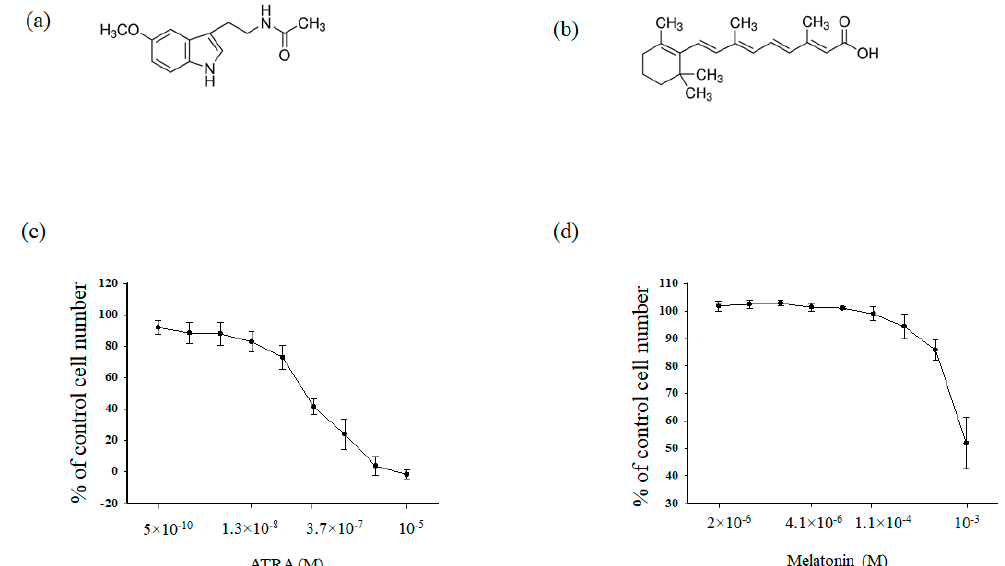
Figure 1. Upper part ( a ) and ( b ). Chemical structures of melatonin (MEL) and all-trans retinoic acid (ATRA). ( a ) MEL, ( b ) ATRA. Lower part ( c ) and ( d ). Concentration dependence of the cytotoxic effects of MEL and ATRA. Cells were seeded in a 96-well plate at a density of 5 × 10 3 cells per well and treated with indicated concentrations of ( a ) MEL and ( b ) ATRA for 96 h. The data are presented as means ± S.D. of ten separate experiments.